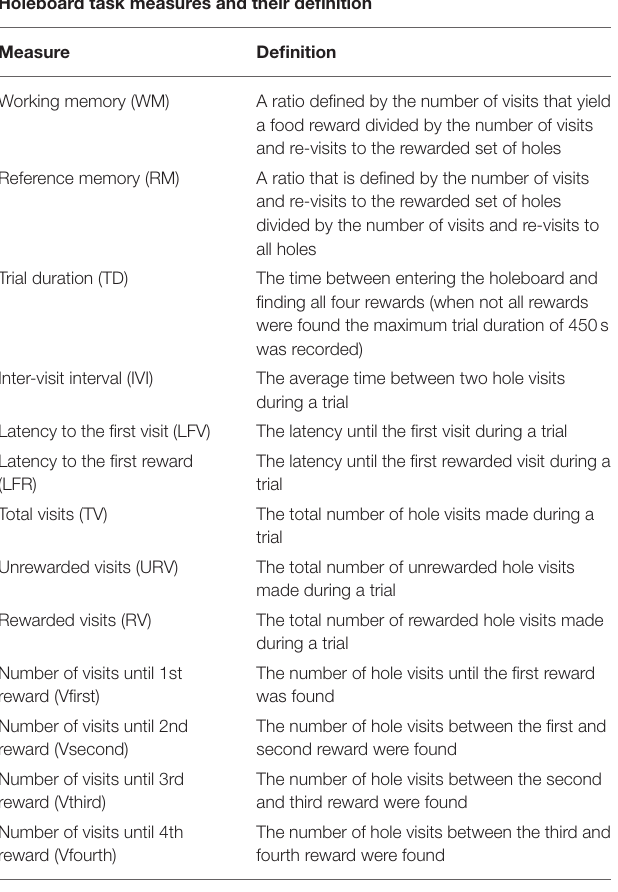
TABLE 2 | Measures recorded or calculated in the holeboard task.